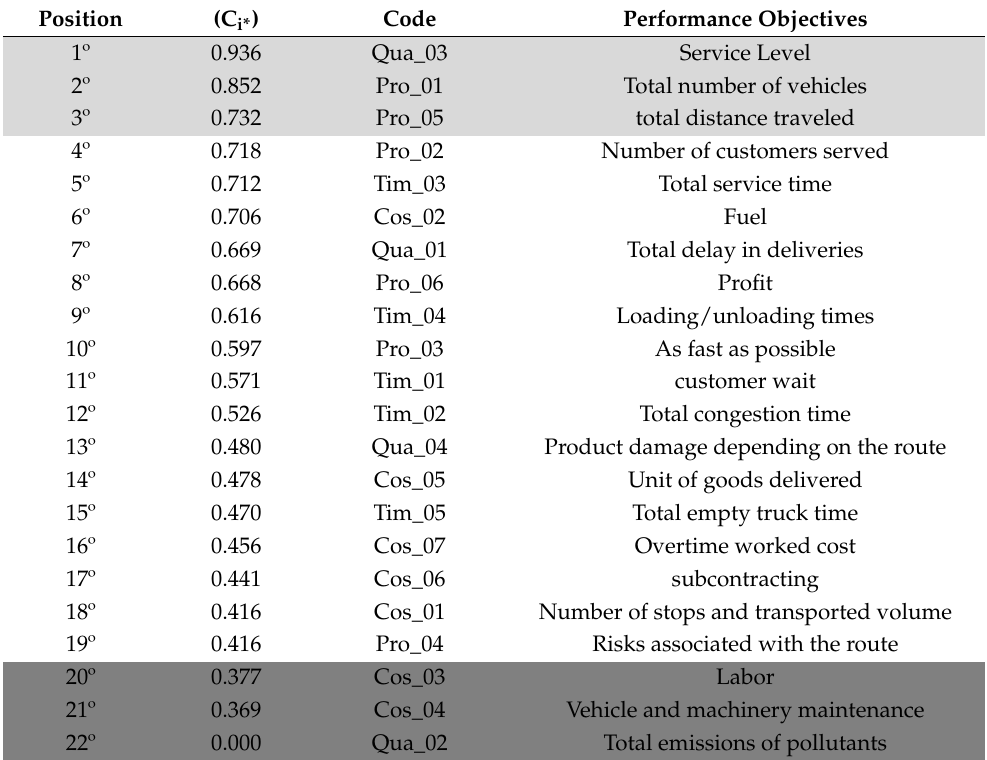
Table 7. Ranking of the items: Source: